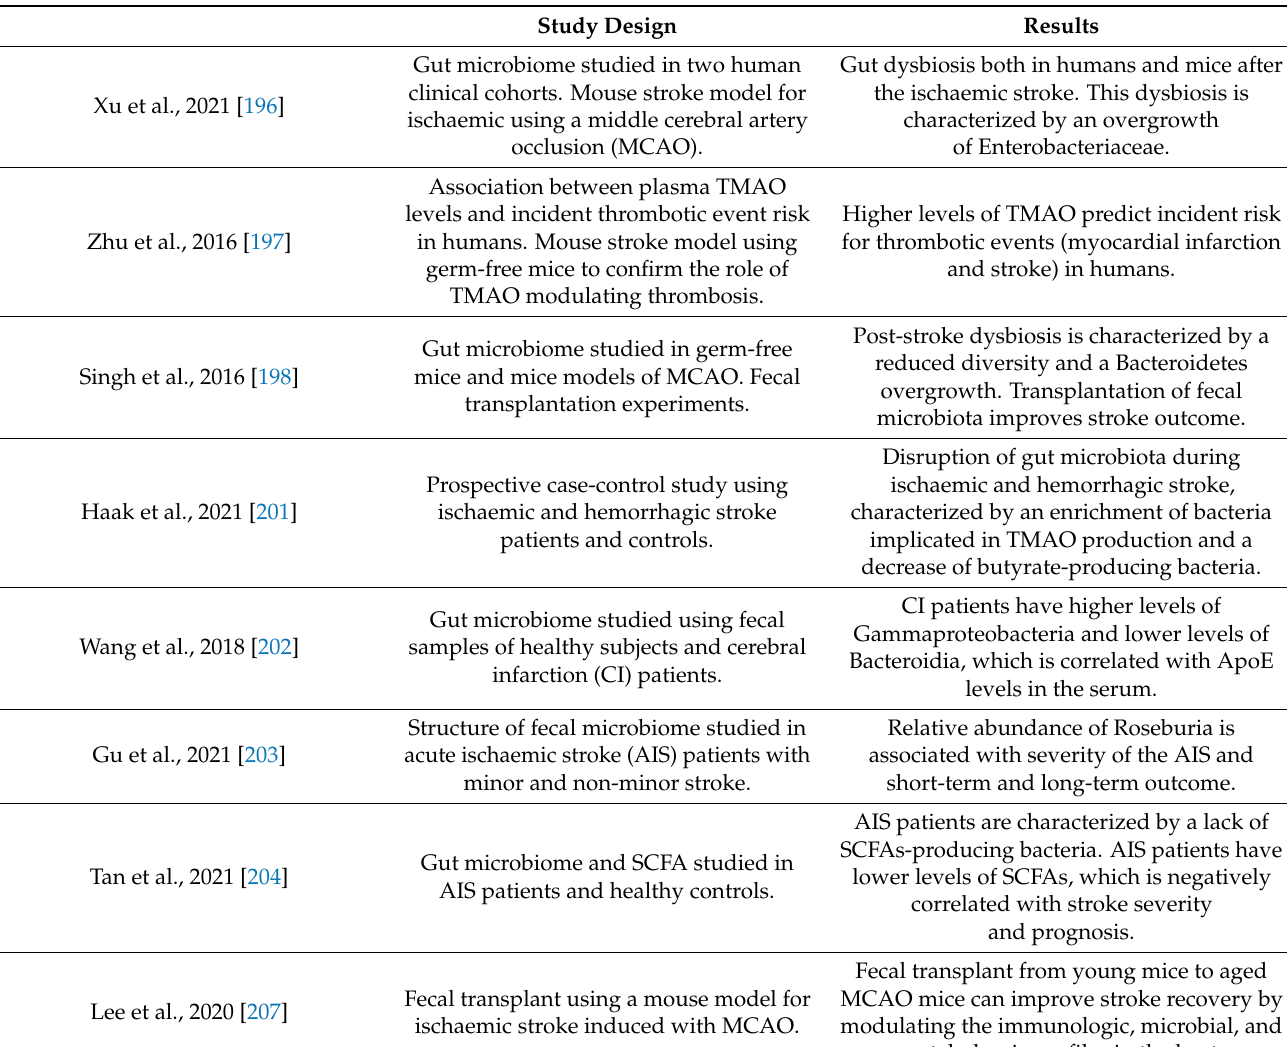
Table 3. Mentioned studies assessing the microbiota-gut-brain axis in ischaemic